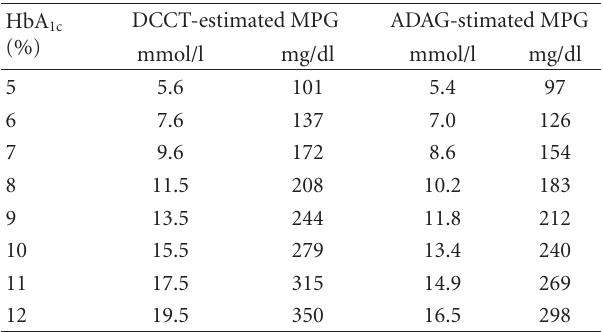
Figure 1: Linear regression analysis of MPG versus HbA 1c : the Pearson correlation coe ffi cient ( r ) is 0.82; MPG (mg / dl) = 35 . 6 × HbA 1c − 77 . 3. Table 1: Regression-estimated MPG at di ff erent HbA 1c levels based on DCCT and Nathan’s